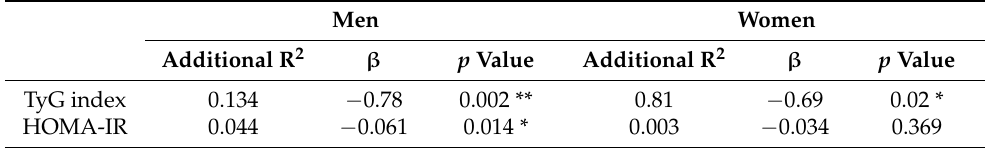
Table 3. Multiple linear regression model for predicting IR.